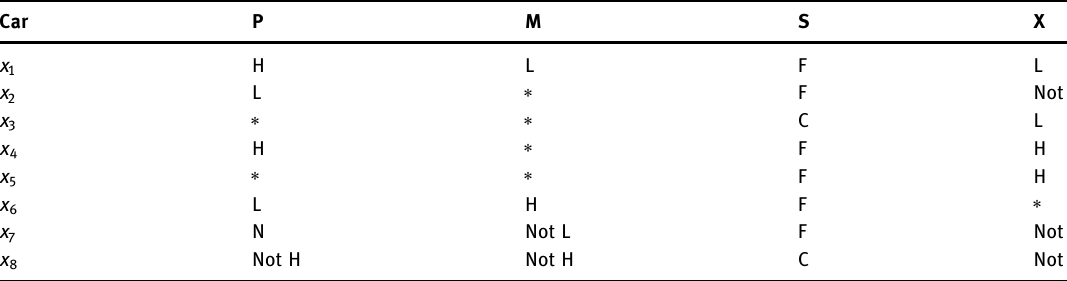
Table 1: An information system of a house evaluation problem Car